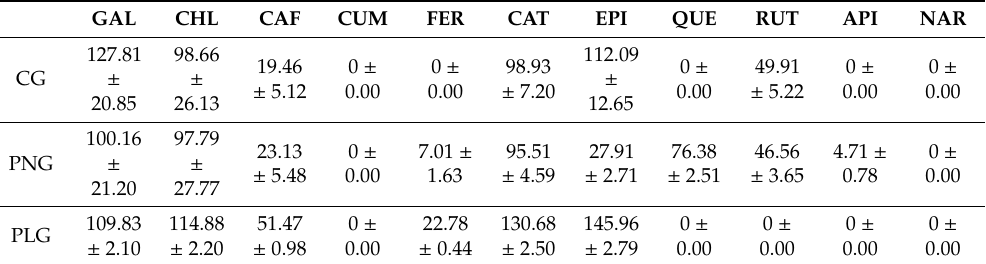
Table 2. Polyphenol composition of the yellow, red and green traditional varieties of sweet pepper of the Campania region, obtained by UPLC analysis, expressed as µ g g − 1 ± Standard Deviation. GAL